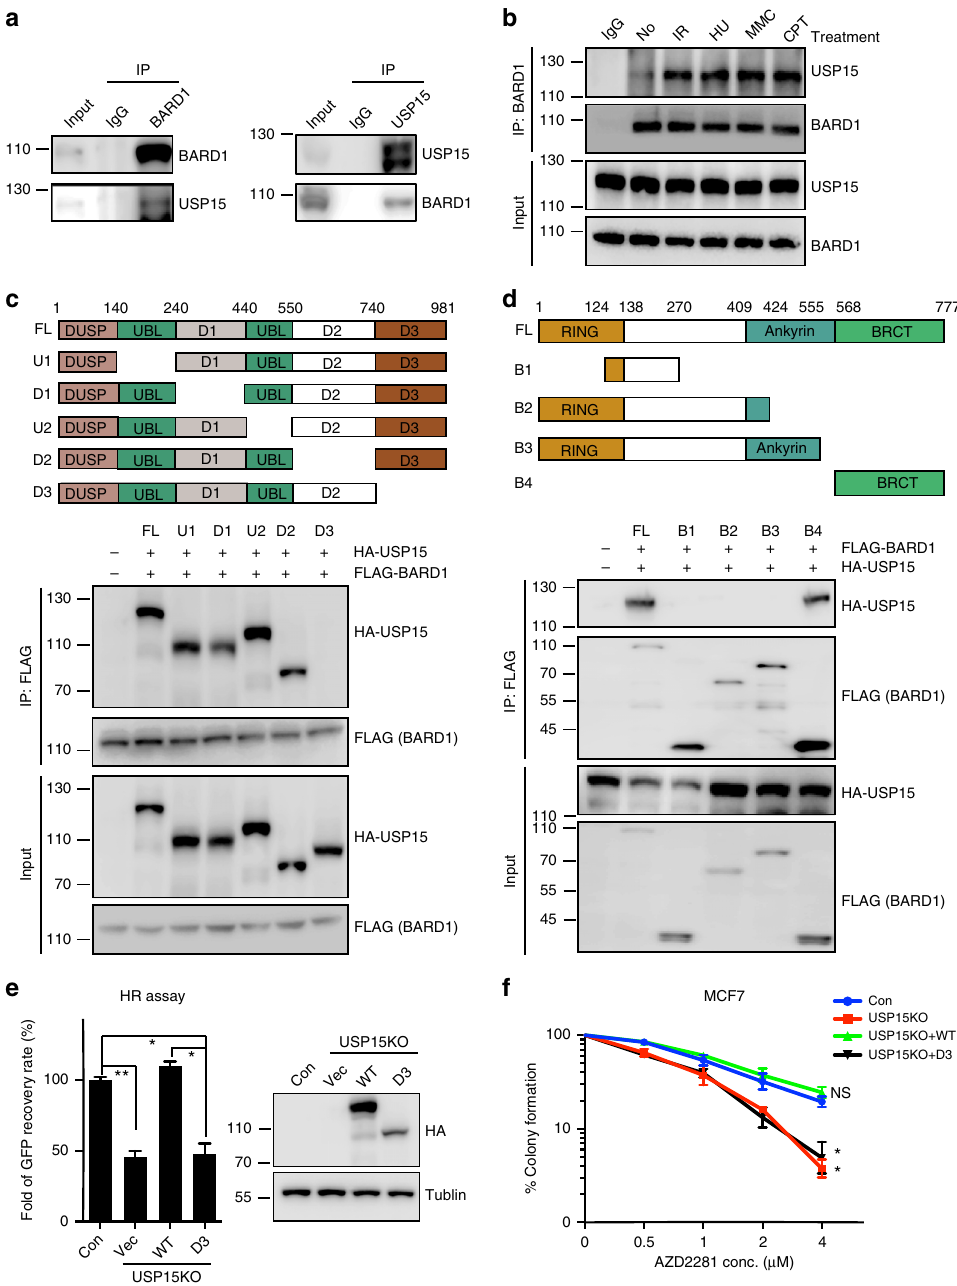
Fig. 2 USP15 interacts with BARD1 BRCT domain through its C-terminal region. a Reciprocal endogenous immunoprecipitation (IP) between USP15 and BARD1 were performed in HEK293T cells. (Left panel) IP with anti-BARD1 antibody and blot with anti-BARD1 or USP15 antibody, respectively. (Right panel) IP with anti- USP15 antibody and blot with anti-USP15 or BARD1 antibody, respectively. b Co-immunoprecipitation (co-IP) assays were performed to check the interaction between USP15 and BARD1 upon DNA damage. HEK293T cells treated as indicated were lysed and immunoprecipitated with anti-BARD1 antibody, and Western blot was performed with indicated antibodies. c Schematic representation of USP15-truncated mutants used in this study (upper panel). Plasmids encoding HA-tagged full-length or deletion mutants of USP15 were co-transfected with plasmids encoding FLAG-tagged full-length BARD1 into 293T cells. Immunoprecipitation and immunoblotting were performed 48h post transfection as indicated. d Schematic representation of BARD1-truncated mutants used in this study (upper panel). Plasmids encoding FLAG-tagged full-length or deletion mutants of BARD1 were co-transfected with plasmids encoding HA-tagged full- length USP15 into 293T cells. Immunoprecipitation and immunoblotting were performed 48h post transfection as indicated. e USP15-knockout U2OS direct repeat green fl uorescent protein (DR-GFP) cells were reconstituted with HA-USP15 wild-type (WT) or D3 mutant and homologous recombination (HR) ef fi ciency were determined. Data are presented as mean±SD of three independent experiments. Two-tailed Student's t test, * P <0.05, ** P <0.01. f The indicated cells “ response to poly-(ADP-ribose) polymerase (PARP) inhibitor (AZD2281) were measured by colony formation assay. Data are presented as mean±SEM of three independent experiments, two-way analysis of variance (ANOVA), * P <0.05. Unprocessed scans of blots are provided in Supplementary Fig.